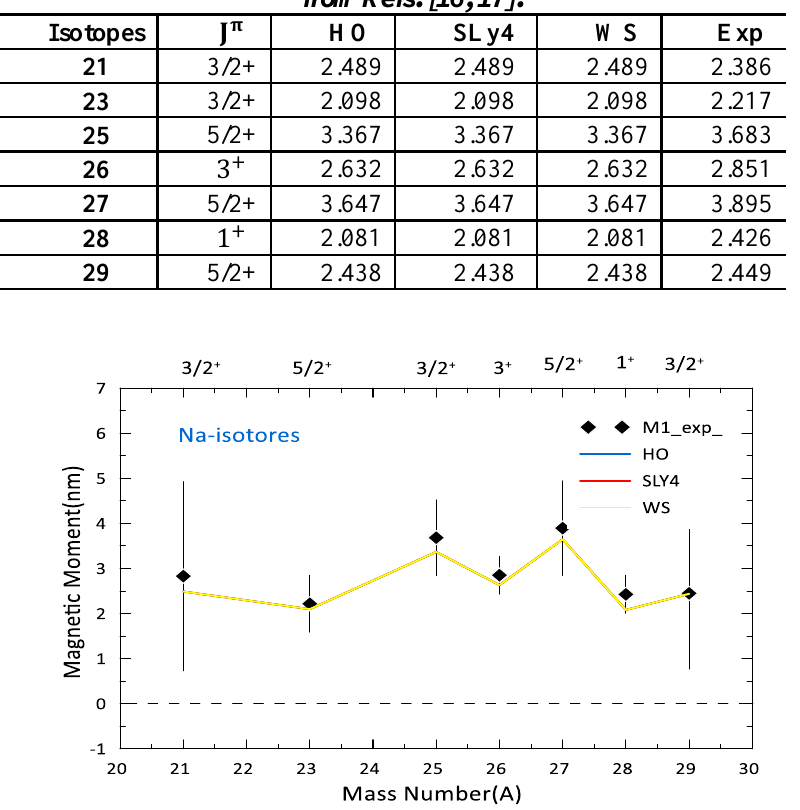
Figure 3: The calculated magnetic dipole moments μ (nm) for Na-isotopes using different single-particle potentials in comparison with the experimental data of Refs. [16,